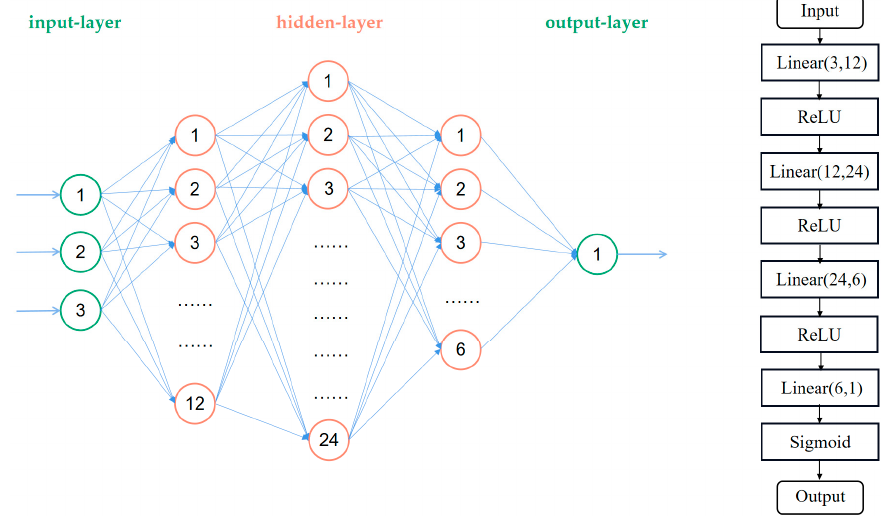
Figure 12. Topology and model structure of DLNet.